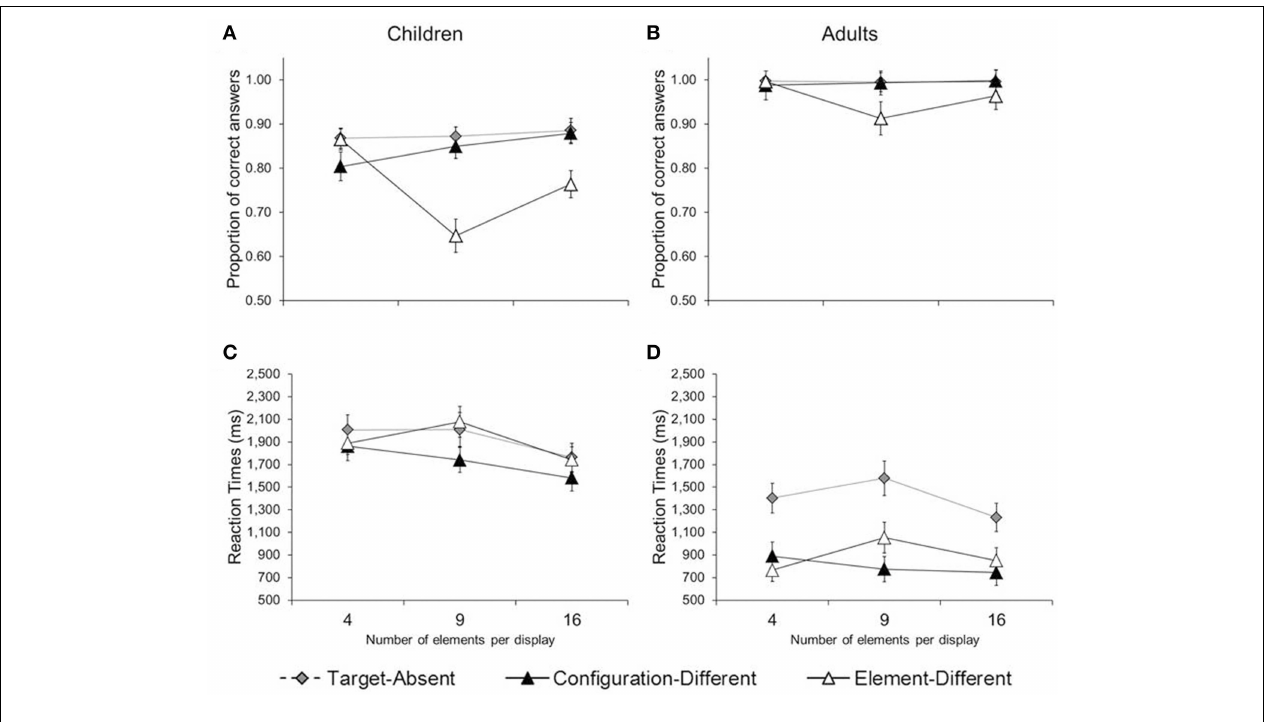
configuration-different, and element-different), and number of elements per configuration (4, 9, and 16). Error bars illustrate the standard